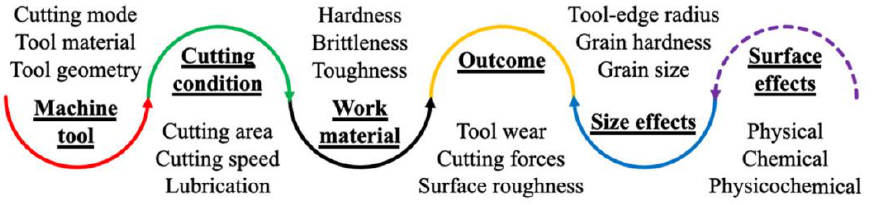
Figure 2. Overview of micro-cutting considerations [6].